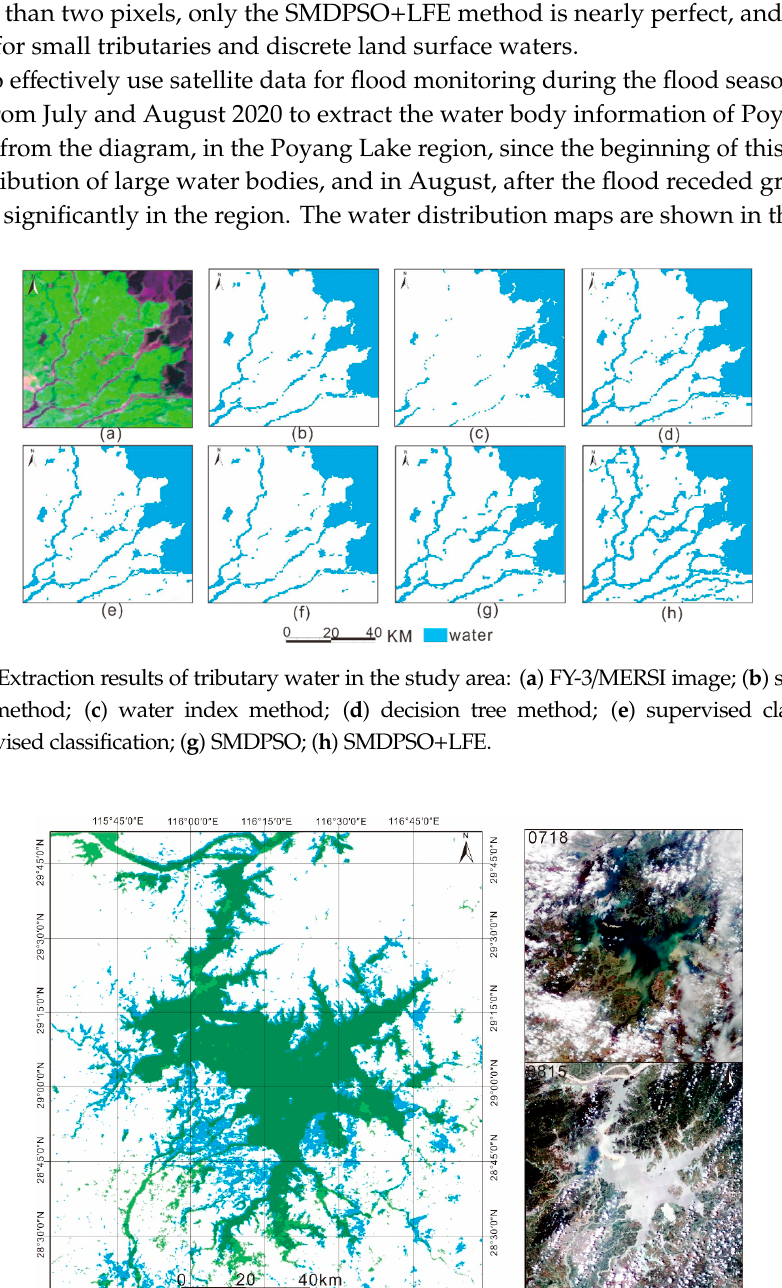
Figure 11. Remote sensing image and water extraction results of the different methods in research area 20160917: ( a ) FY-3/MERSI image; (b) Landsat data; ( c ) single-band threshold method; ( d ) water index method; ( e ) decision tree method; ( f ) supervised classification; ( g ) unsupervised classification; ( h ) SMDPSO; ( i ) SMDPSO+LFE.